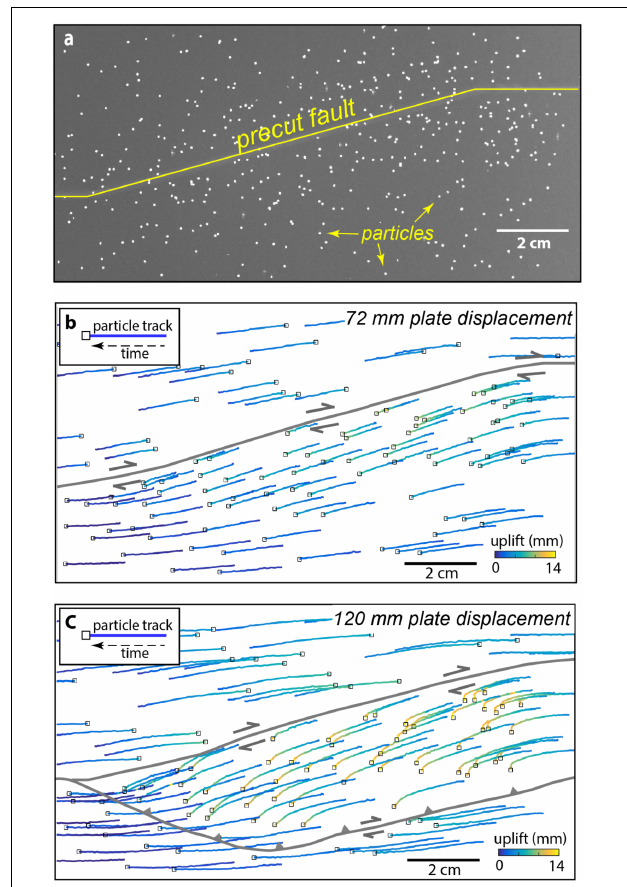
FIGURE 6 | (a) Inverted photo used for PTV analysis with black markers on off-white kaolin at the start of the experiment. Flow paths generated from particle tracking velocimetry (PTV) show material migrating through a 15 ◦ restraining bend claybox experiment in a fault-fixed reference frame. Color indicates uplift history of each particle. (b) Early in the experiment displacement is predominantly parallel to the fault with modest uplift. (c) With growth of the new oblique-slip fault, the particles change trajectory and